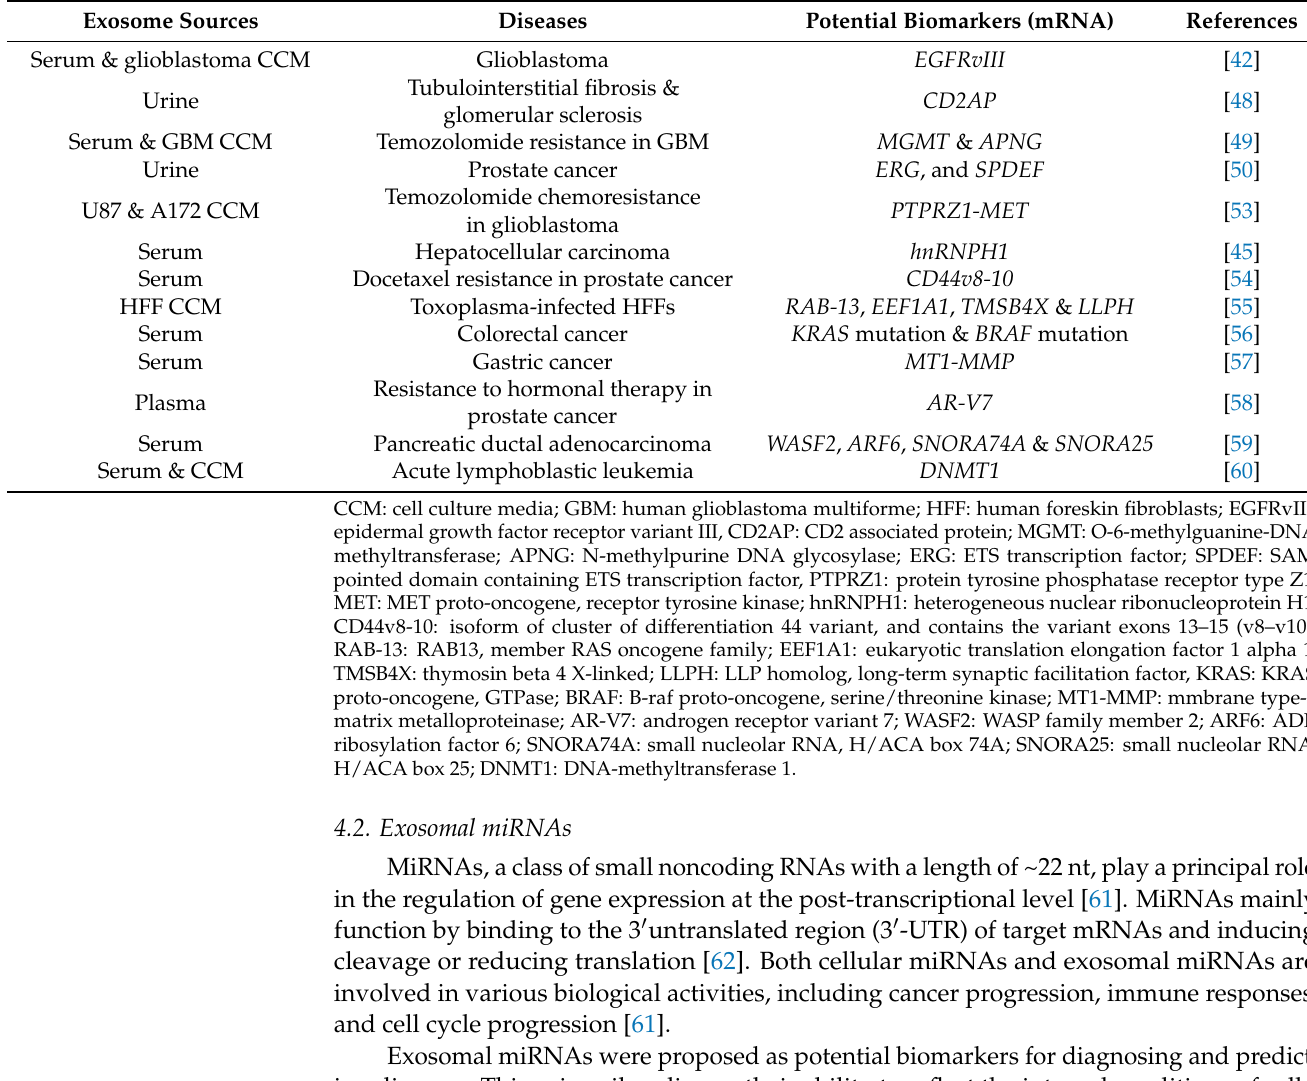
Table 1. Summary of exosomal mRNAs as potential disease